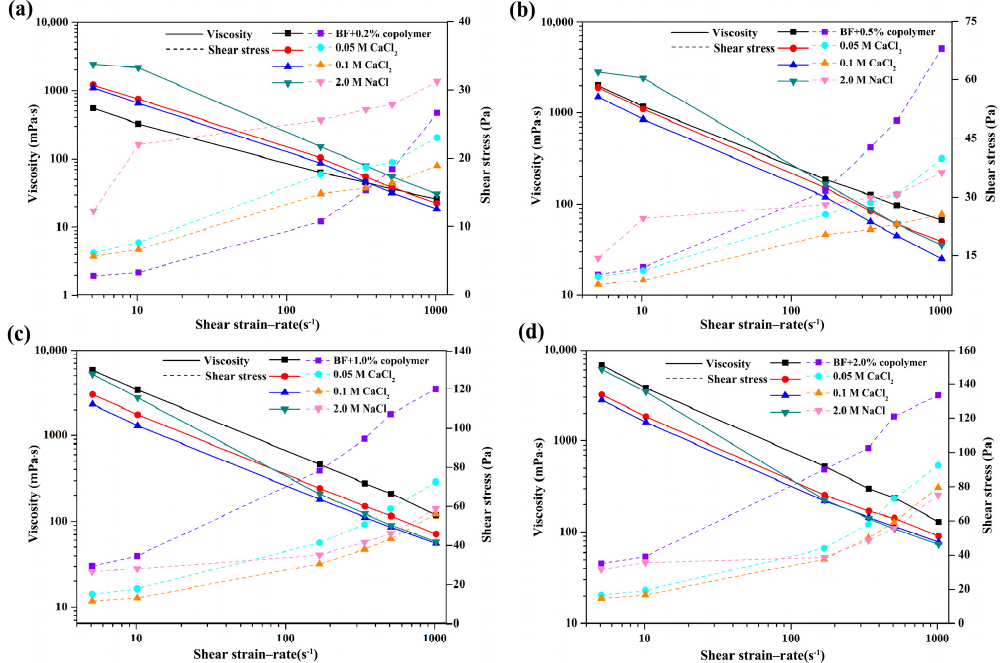
Figure 7. Apparent viscosity and shear stress as a function of the shear rate of BF and BF/ PADAD ( a ) 0.2 wt%, ( b ) 0.5 wt%, ( c ) 1.0 wt%, ( d ) 2.0 wt% with different concentrations of electrolytes ((NaCl or CaCl 2 ) at 25 °C.